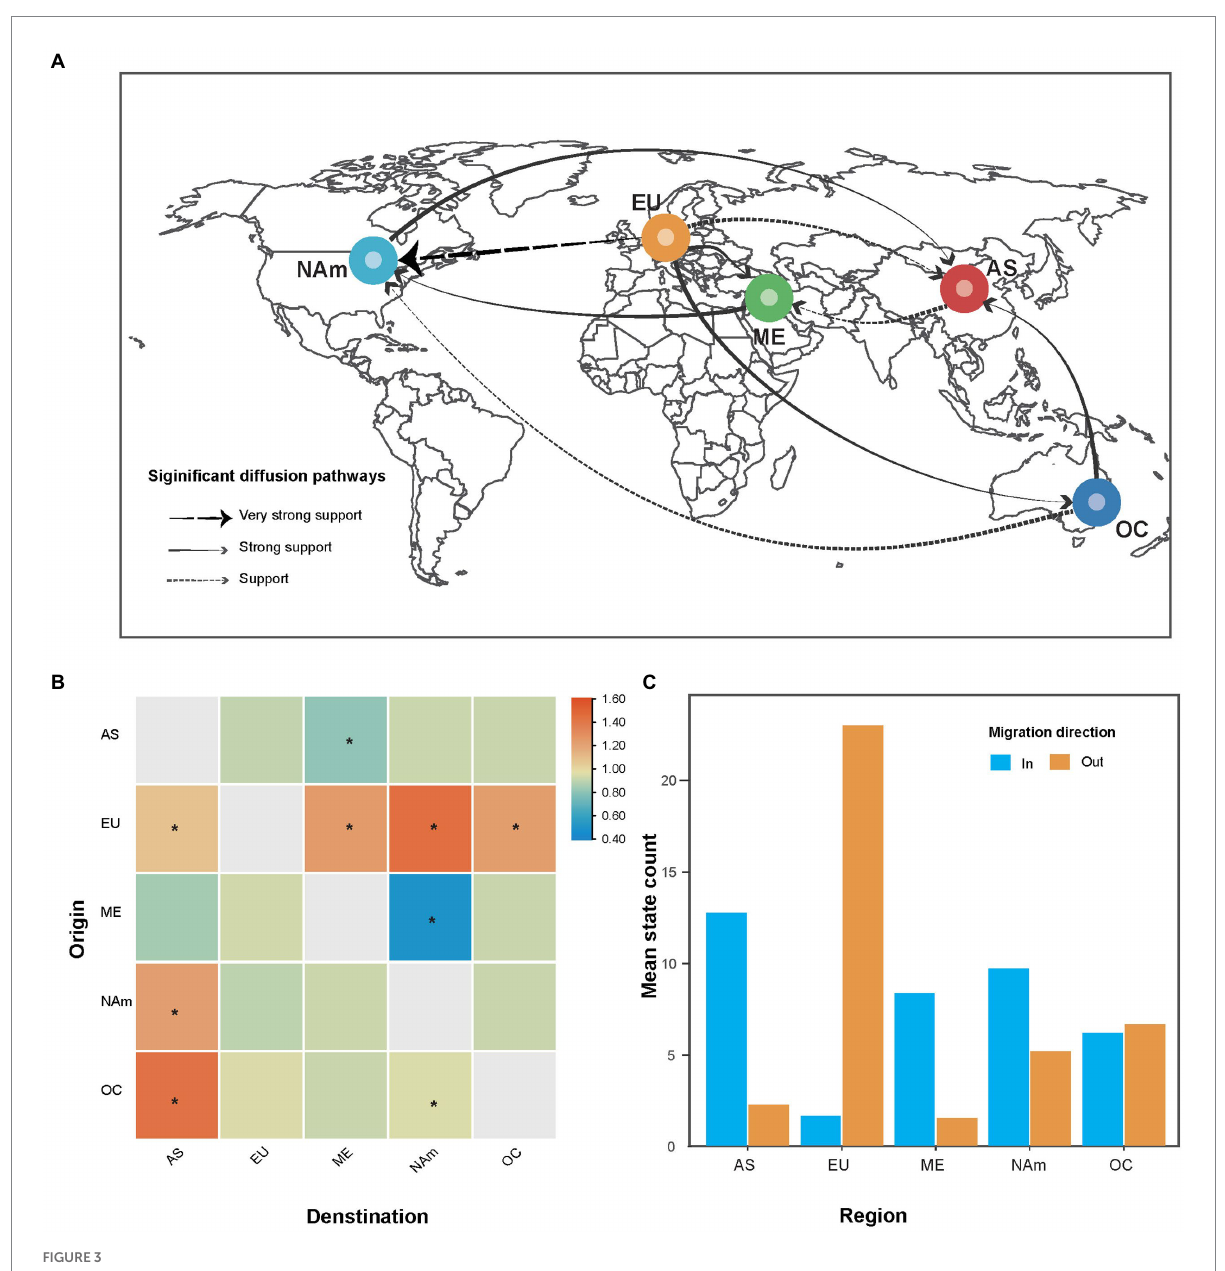
FIGURE 3 The spatial dynamics analysis of alfalfa mosaic virus (AMV). (A) Spatial diffusion pathway, (B) asymmetric migration rate matrix of AMV between each pair of regions, and (C) histograms of the total number of location-state transitions. Bayes factor (BF) > 3 and mean indicator of >0.5. Dashed black arrows, very strong support with 150 < BF < 1,000; solid grey arrows, strong support with 20 < BF < 150; and dashed grey arrows with BF < 20. The asterisks at the center of the cell indicate supported rates with 3 < BF < 20. AS, Asia; EU, Europe; ME, Middle East; NAm, North America; OC,